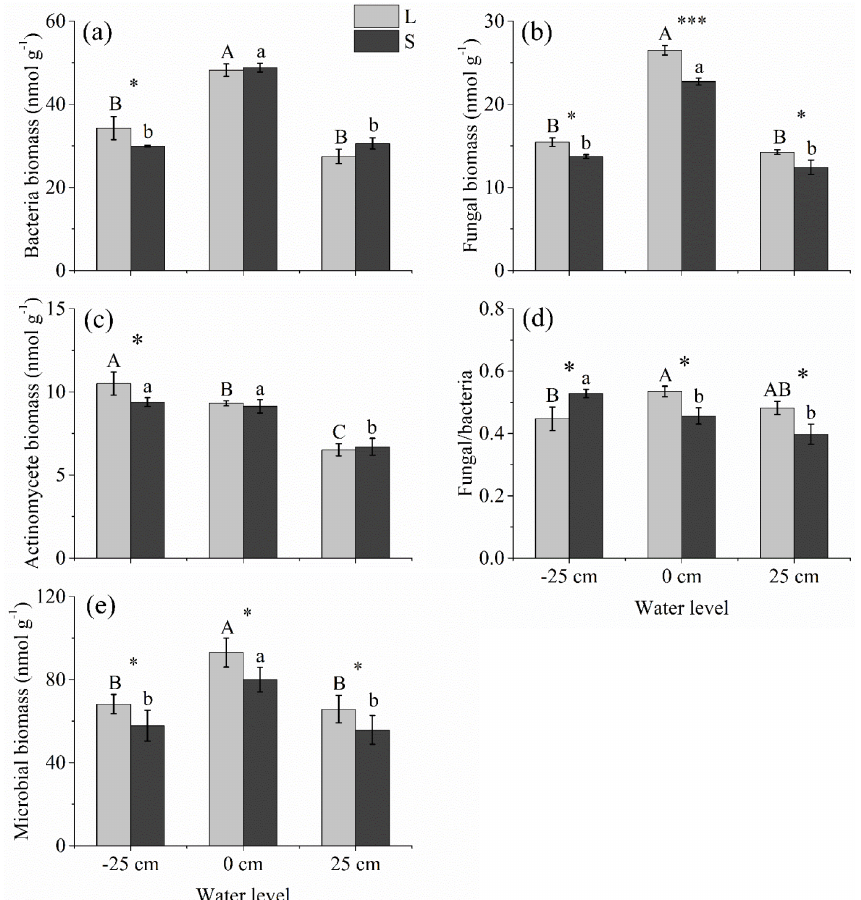
Figure 4. Microbial community structure under litter input and litter removal at three water levels. Different uppercase letters among vertical bars indicate significant differences among the three water levels in the litter input (L) group. Different lowercase letters indicate significant differences among the three water levels in the litter removal (S) group. The significance level is α = 0 . 05. *, **, and *** represent significant differences between the litter input (L) and litter removal (S) groups at the three water levels at the 0.05, 0.01, and 0.001 significance levels,